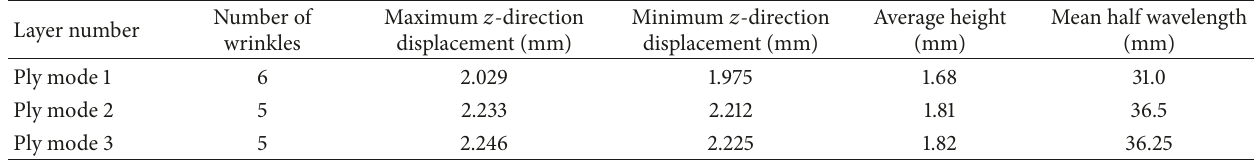
Table 14: The geometrical features of different ply modes laminated